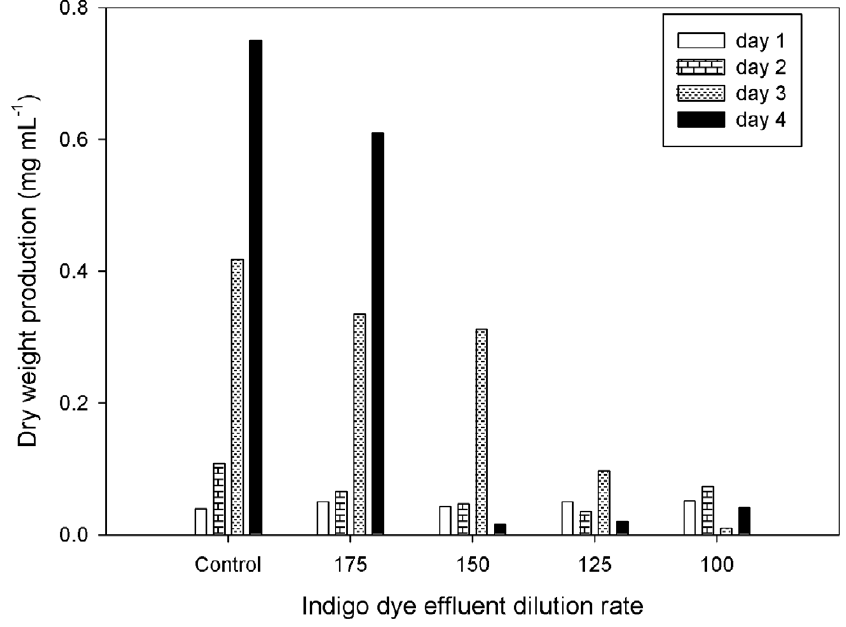
Fig. 3 - Dry weight production (mg L -1 ) by Scenedesmus quadricauda when grown at different indigo dye effluent